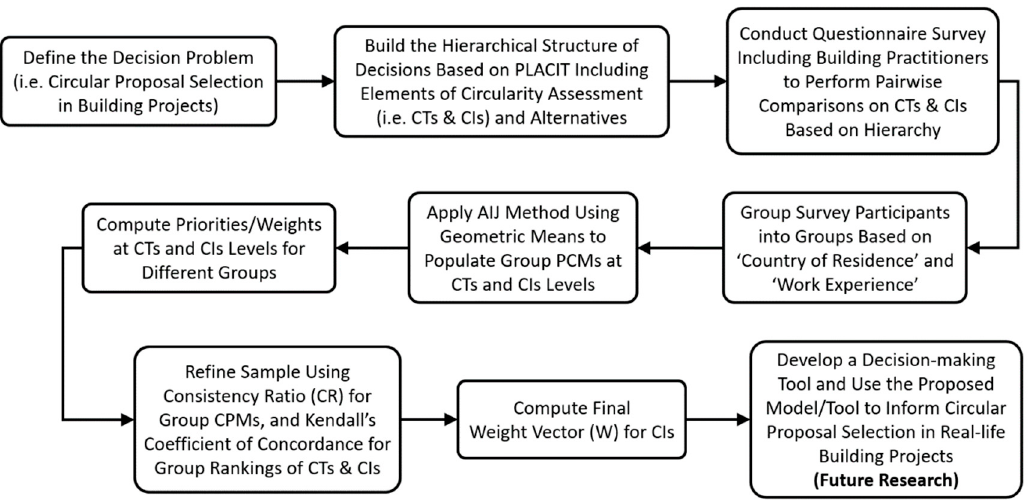
Figure 1. Steps followed to develop AHP decision-making model based on PLACIT.